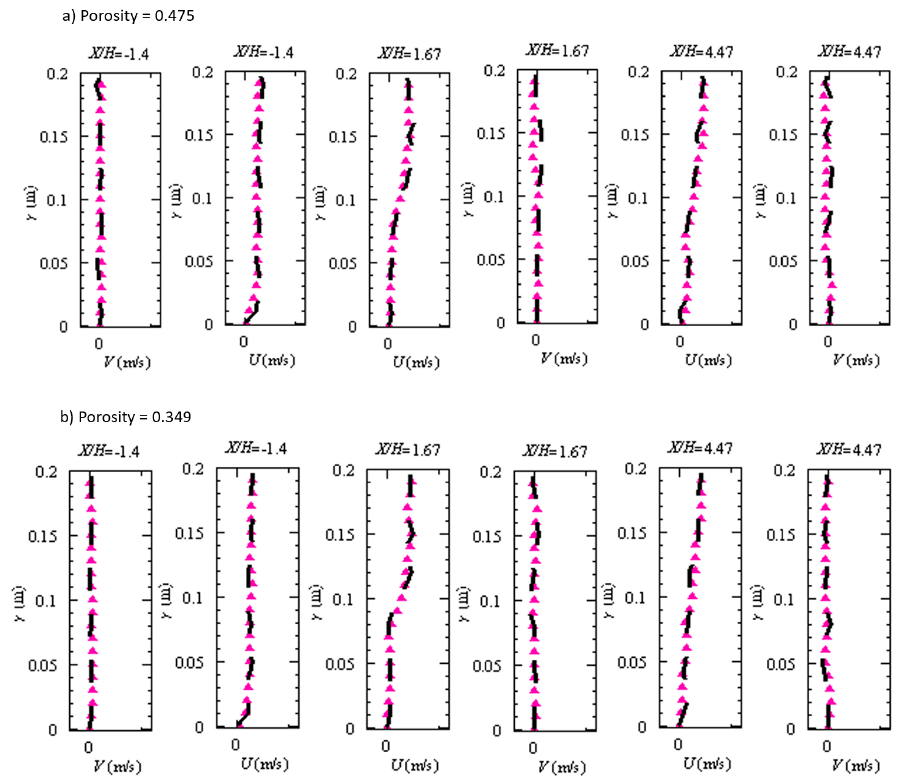
Figure 8. Solid purple triangle D = 0.0104; Dashed line when D = 0.01. X / H = − 1.4 indicates the oncoming flow field of the pore structure; X / H = 1.67 indicates that the water flows through the pore structure field; X/H = 4.47 indicates the back vortex field of the pore; Y (m) indicates that the particles of the water flow from the horizontal plane vertical distance; U (m/s) represents the longitudinal water flow velocity; V (m/s) represents the vertical water flow velocity.